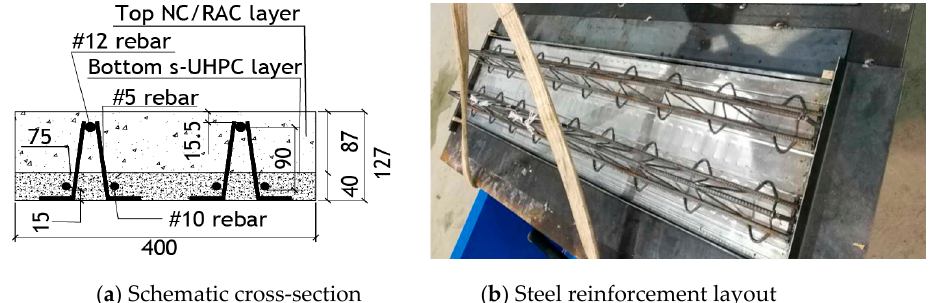
Figure 2. Details of deck type A (units in mm).